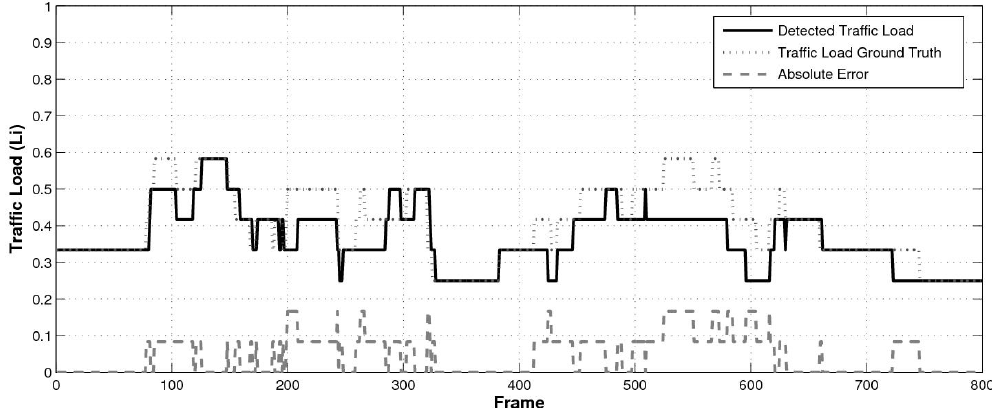
Figure 19. Estimated average road speed ( v